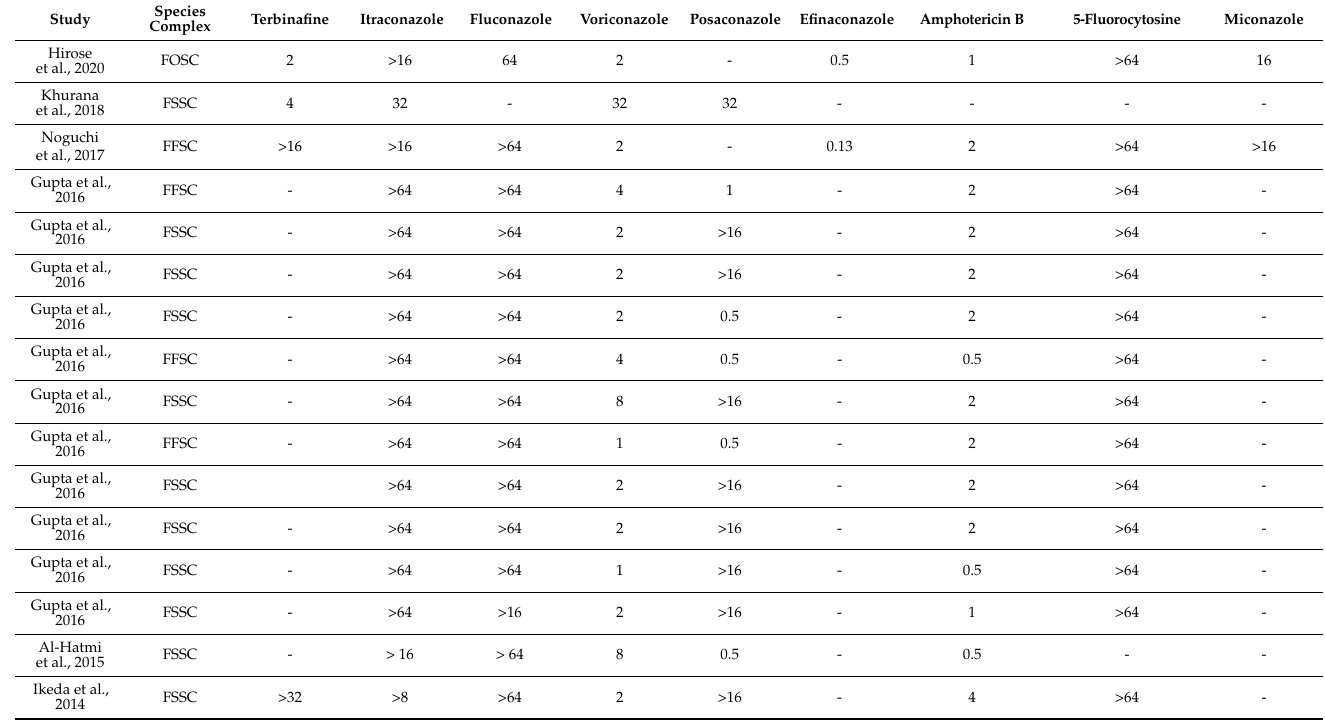
Table 4. Range of minimum inhibitory concentration (MIC) of common antifungal agents described for Fusarium spp. causing onychomycosis ( µ